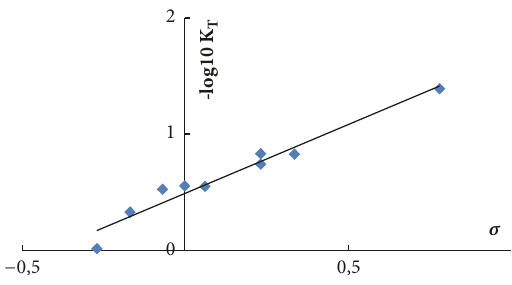
Figure 1: Plot of -log K